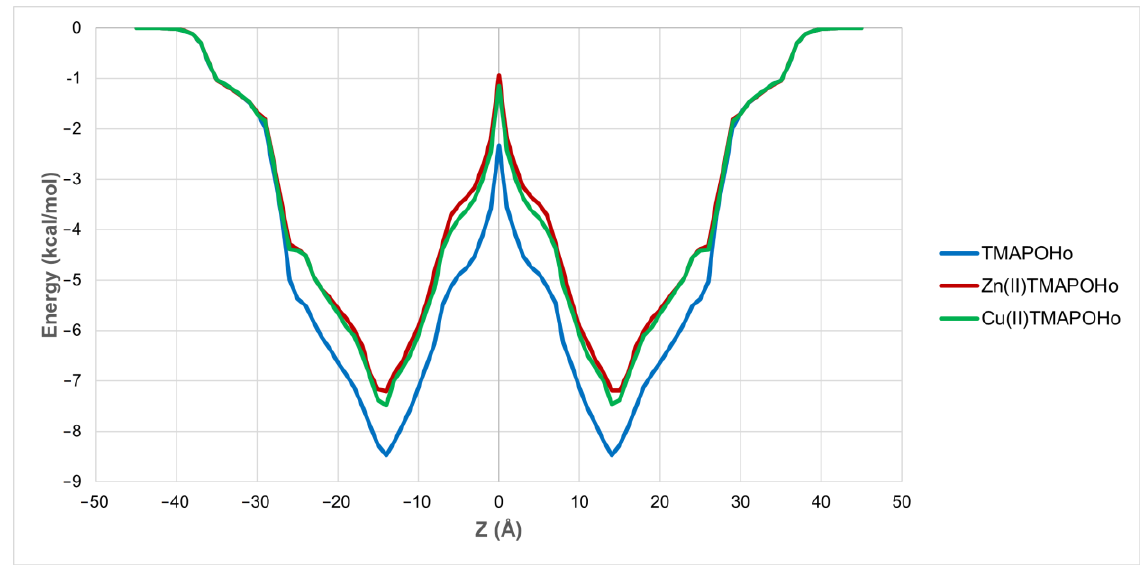
Figure 4. Variation of free energy of binding in relation to the distance from the membrane center (Z).